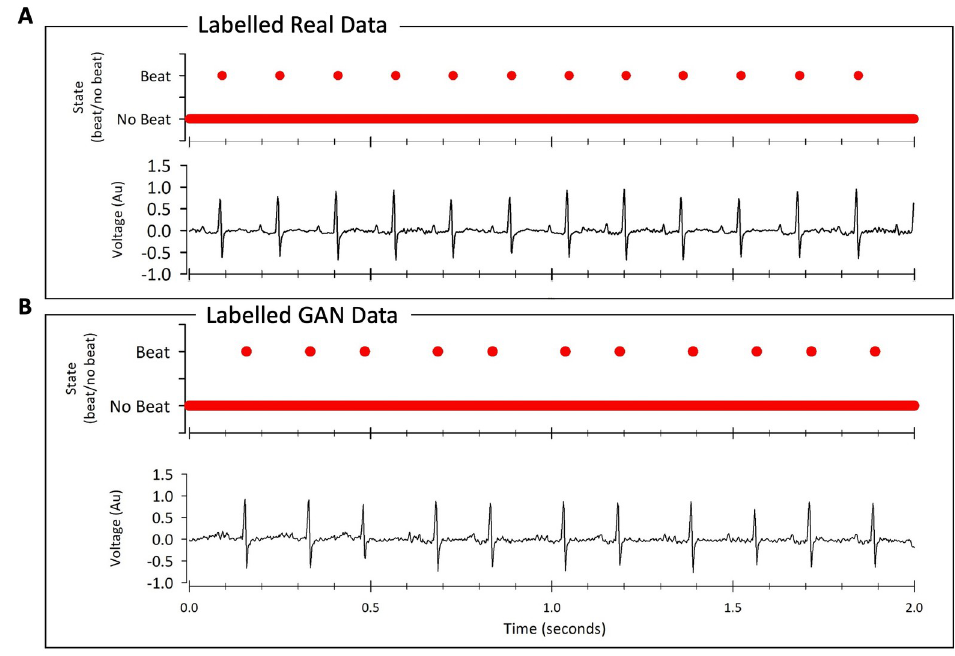
Fig 8. General usability of DeepGANnel for 2-dimensional physiological time series data. In this example we fed rodent ECG data (dimension 1) along with a beat annotation (dimension 2, peak of r-wave) into DeepGANnel and trained with 10,000 epochs until realistic rodent ECG data was generated. Data collected via electrocardiogram transmitters from male Wistar rats (ETA-F20; Data Sciences International, St Paul, MN, USA) as previously described [43], briefly ECG signal was digitized to a PC with a CED Micro1401 using Spike2 at 5 kHz. In principle this could also be encoded with further annotations such as t-wave (note rats do not show a significant